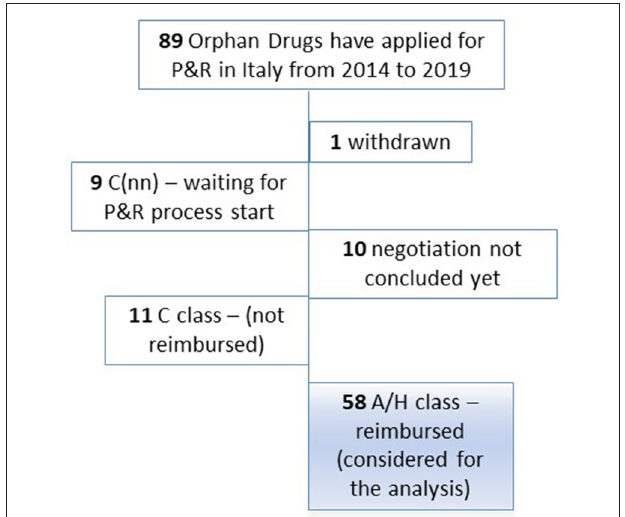
FIGURE 3 | Correlation analysis between the log of the annual therapy cost (calculated on the Final Price) and the prevalence of the disease. (negative but not statistically significant, p- value: 0.49)